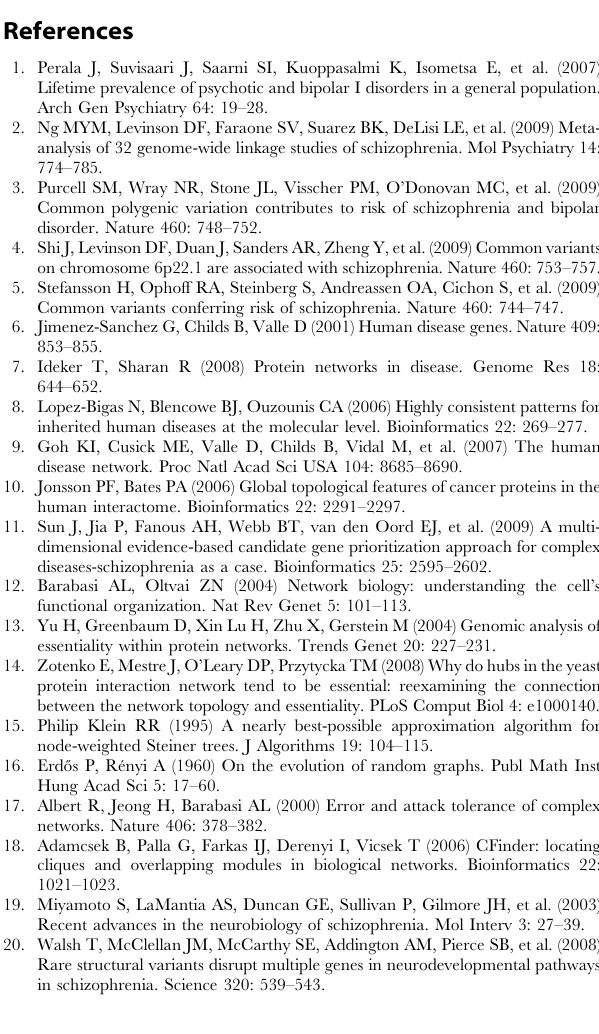
Figure S4 Selection of novel schizophrenia candidate genes. Nodes in red denote SZGenes and nodes in grey and green denote non-SZGenes. (A) Direct interactors of five potential schizophre- nia candidate genes (in green), which are non-SZGenes but had P values , 0.05 in both GAIN and CATIE GWA studies. In these subnetworks, the nodes whose genes having P value , 0.05 in GAIN are labeled in red asterisk and having P value , 0.05 in CATIE are labeled in blue asterisk. (B) An extracted glutamate receptor signaling